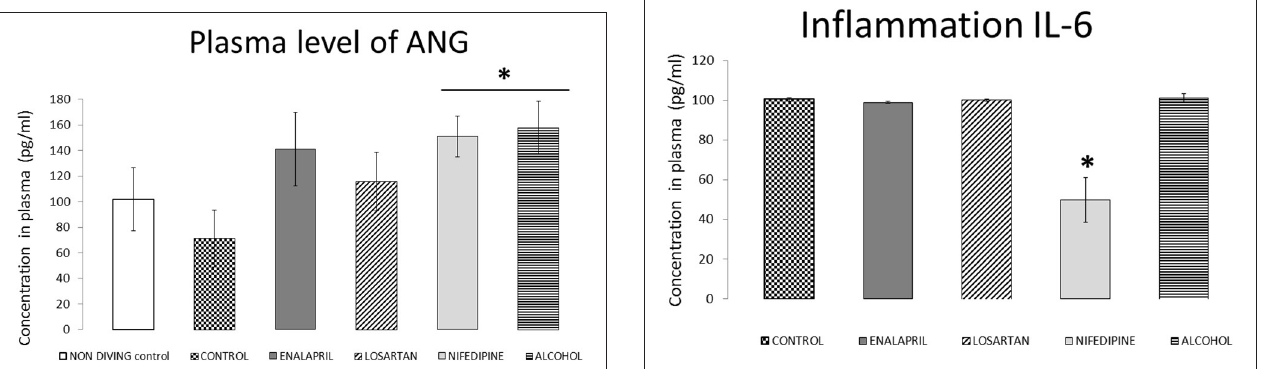
FIGURE 4 | ANG plasma levels for all diving groups with treatment compared with diving control and non-diving rats. ANG plasma levels expressed as pg/ml (mean ± SEM), for all the diving groups with treatment compared with diving control and non-diving rats. * p < 0.05.